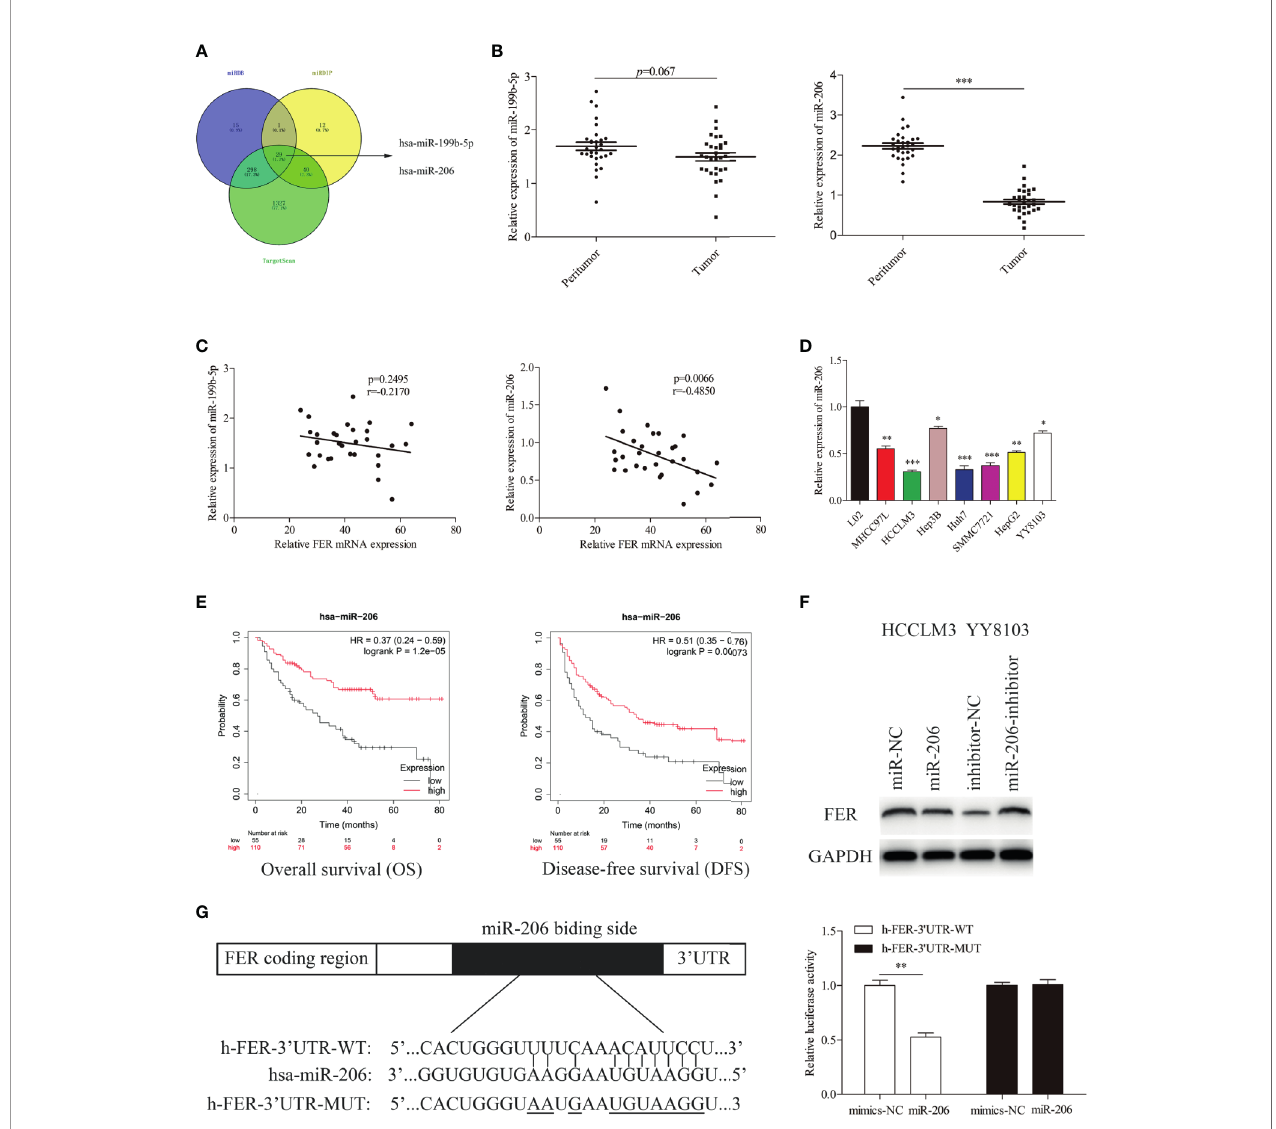
FIGURE 6 | miR-206 directly targets FER in HCC cells. (A) Venn diagram showing miR-206 and miR-199b-5p computationally predicted to target FER by three databases. (B) Relative miRNA expression levels in 30 pairs of HCC tissues were determined using qRT-PCR. (C) Spearman correlation analysis revealed the association between FER and candidate miRNAs in the 30 HCC samples. (D) The expression level of miR-206 in HCC cell lines and the L02 cell line. (E) The overall survival (OS) and disease-free survival (DFS) of HCC patients with different miR-206 expression levels (data from Kaplan-Meier Plotter). (F) The expression level of FER was analyzed in HCCLM3 cells transfected with the miR-206 mimic or miR-NC and YY8103 cells transfected with the miR-206 inhibitor or inhibitor NC. (G) The predicted miR-206 targeting sequence in the FER-3 ’ UTR (FER-3 ’ UTR-WT), and luciferase activity, as detected in a luciferase reporter assay. (*P < 0.05, **P < 0.01, ***P <